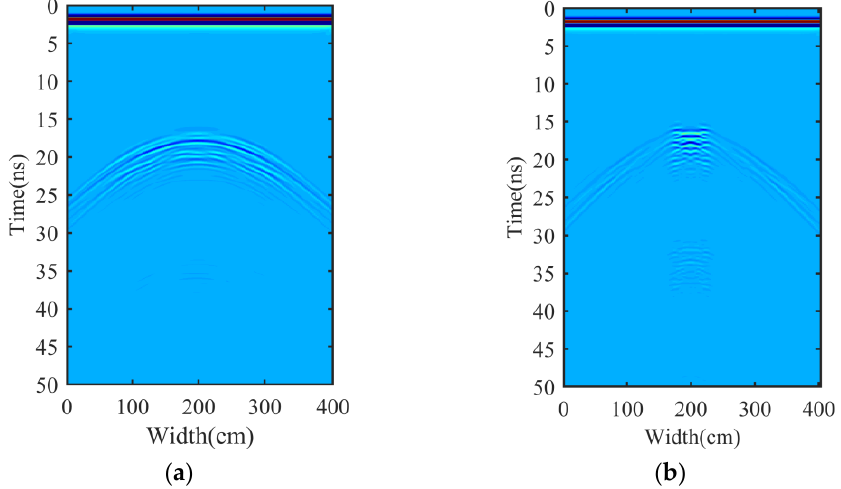
Figure 10. GPR B-scan image of a disease model with an irregular cavity above pipeline: ( a ) Obtained by non-conformal method; ( b ) Obtained by the conformal method.